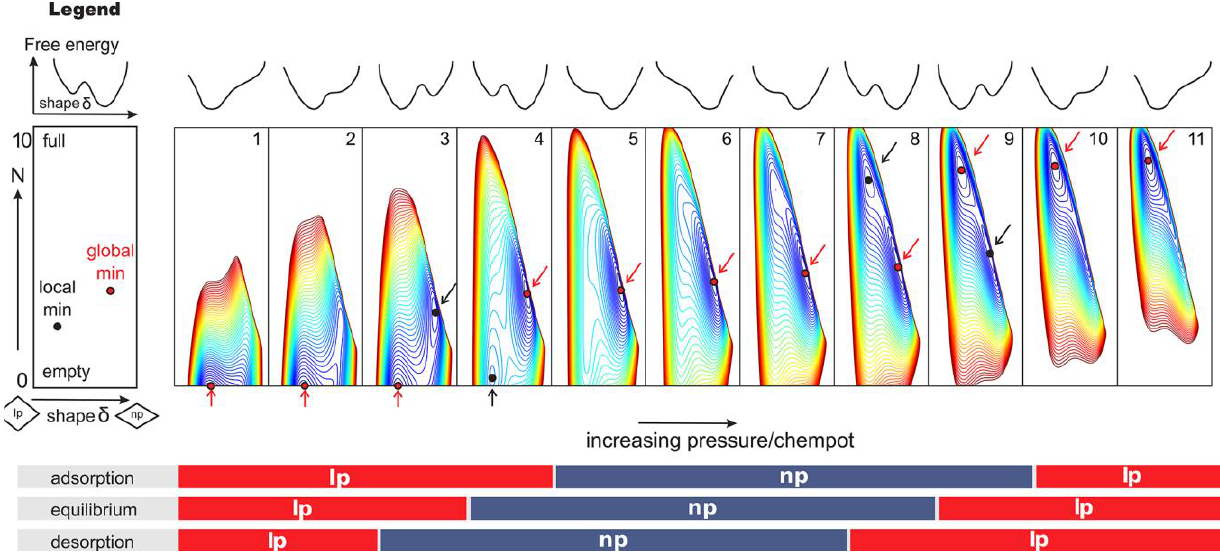
Figure 24. Neutron powder diffraction of MIL-53(Al) collected at ( a ) an elevated temperature ( lp form); ( b ) room temperature ( np form). The π–flipping of BDC ligands and the distortion of octahedral metal nodes can be visualized in the inset and ( c ). Reprinted with permission from [112]. Copyright 2008 American Chemical Society. [27]. Copyright 2007 WILEY-VCH Verlag GmbH & Co. KGaA,